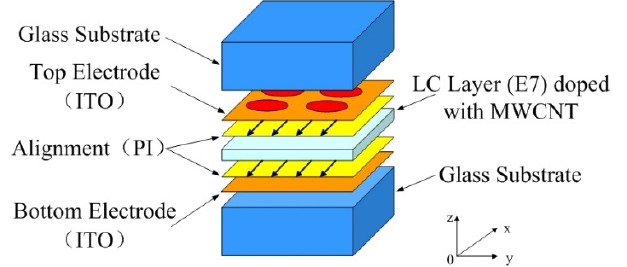
Figure 1. The schematic structure of the liquid crystal (LC) microlens.